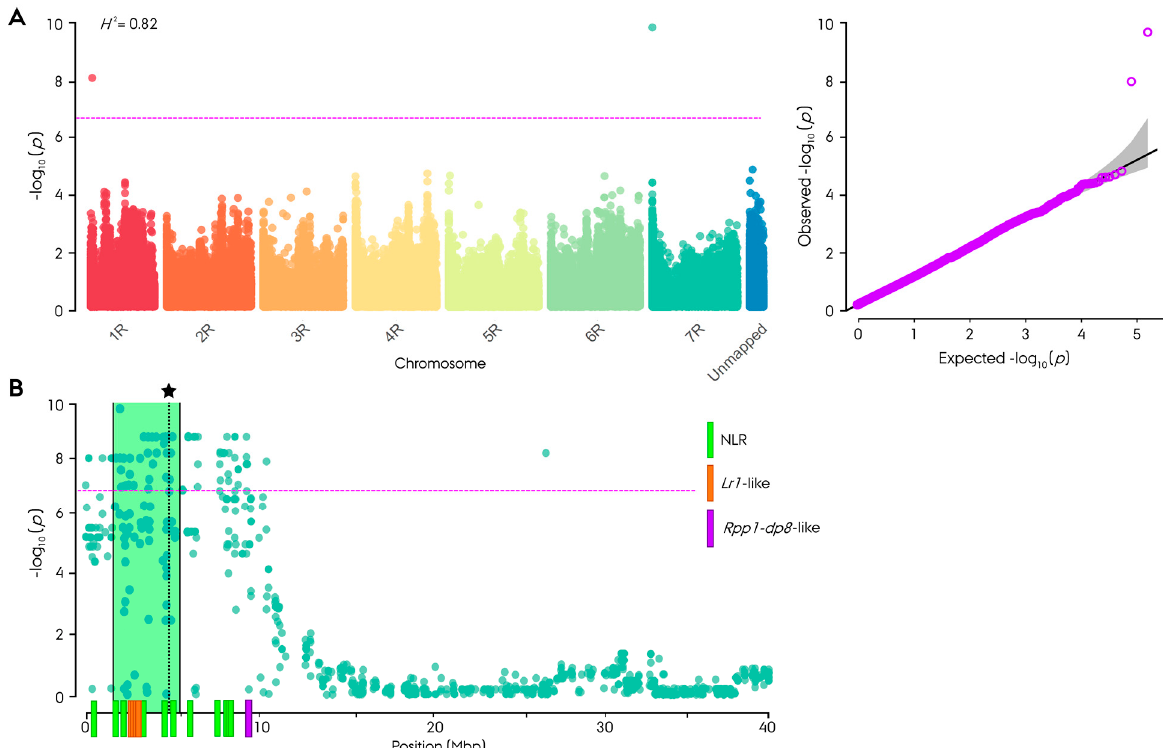
Figure 3. Manhattan plot for genome-wide association study (GWAS) using BLINK method on leaf rust disease resistance in 180 hybrid rye ( Secale cereale L.) breeding lines using 261,406 informative SNP markers anchored to the Lo7 reference genome. ( A ) Using best linear unbiased estimator (BLUE) resistance value across four field trials in 2019 and 2020 for the entire germplasm as phenotypic input, including Q-Q plot. ( B ) Excerpt of the chromosome arm 7RS from GWAS using the same phenotypic input as in ( A ) with MLM method instead. The span of most associated marker position is highlighted in green, mean position of most associated marker by an asterisk and NLR genes in the Lo7 reference genome by vertical bars. The purple line represents the Bonferroni-adjusted significance threshold based on informative markers.